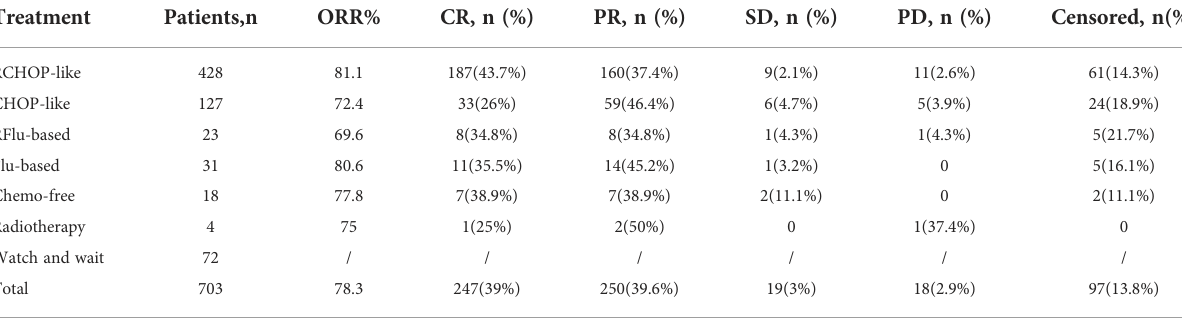
TABLE 2 The fi rst-line treatment model and clinical response in the 1 – 3a FL cohort. Treatment